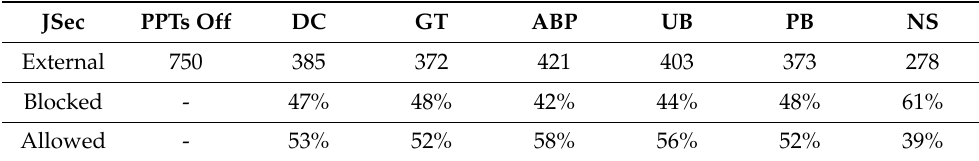
Table 4. The percentage of all allowed and blocked external JavaScript